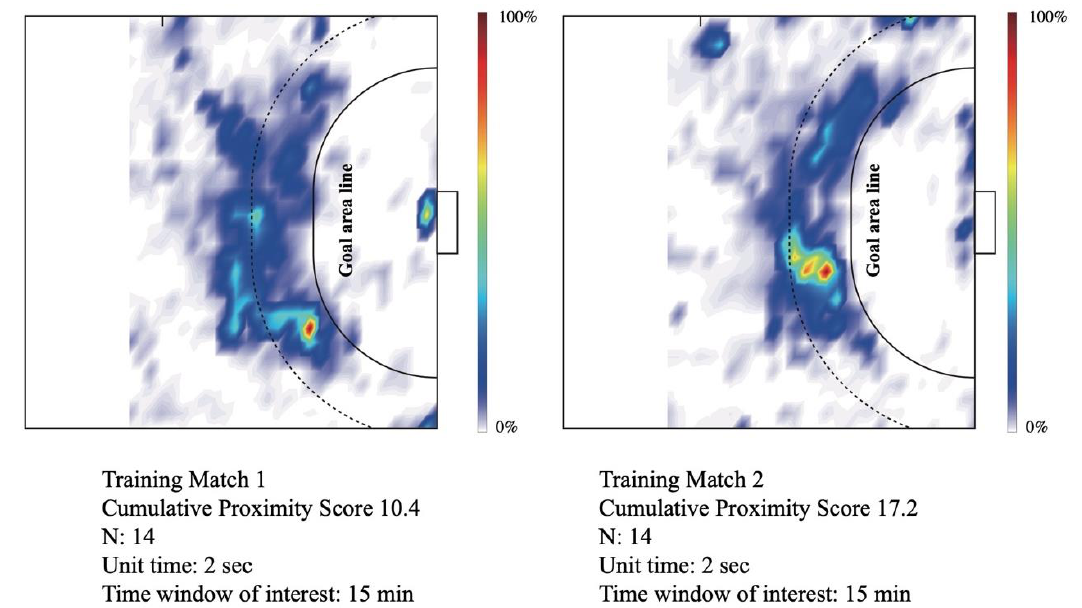
Figure 4. Heat map of area-specific proximity density on the handball court during training matches. The color map represents a 0 to 100% scaled value from areas where no proximity IDs were observed (0%, white) to areas where the most frequent proximity IDs were observed (100%, dark red) during the time window of interest.